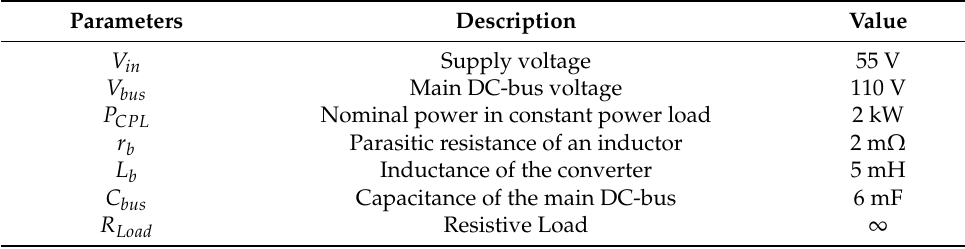
Table 1. Nominal system parameters of the